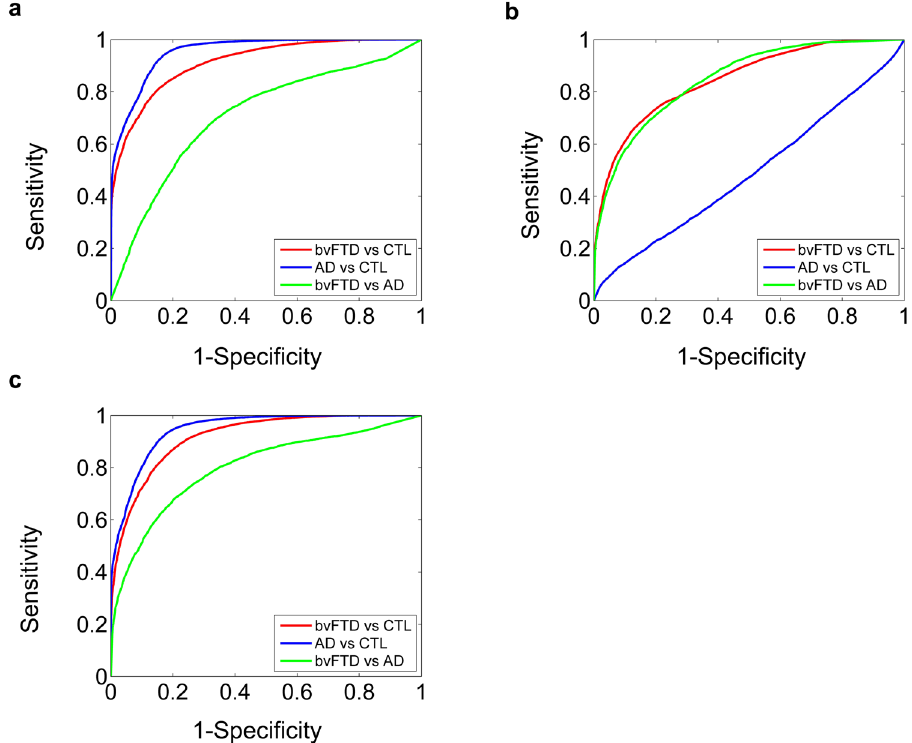
Figure 4. ROC curves for classification analyses. We calculated ROC curves for each classification with their corresponding groups of variables. Then the AUC were calculated to evaluate classification power. The AUC values yielded similar classification rates as those obtained in the other classification analyses. ( A ) ROC curves for classifications using neuropsychological variables. AUC values: bvFTD patients vs. controls = 0.76, AD patients vs. controls = 0.77, and bvFTD patients vs. AD patients = 0.65. ( B ) ROC curves for classifications using connectivity variables. AUC values: bvFTD patients vs. controls = 0.73, AD patients vs. controls = 0.54 and bvFTD patients vs. AD patients = 0.73. ( C ) ROC curves for classification using both neuropsychological and connectivity variables. AUC values: bvFTD patients vs. controls = 0.78, AD patients vs. controls = 0.77, and bvFTD patients vs. AD patients =